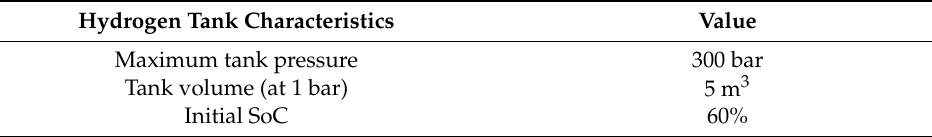
Table 6. Hydrogen tank